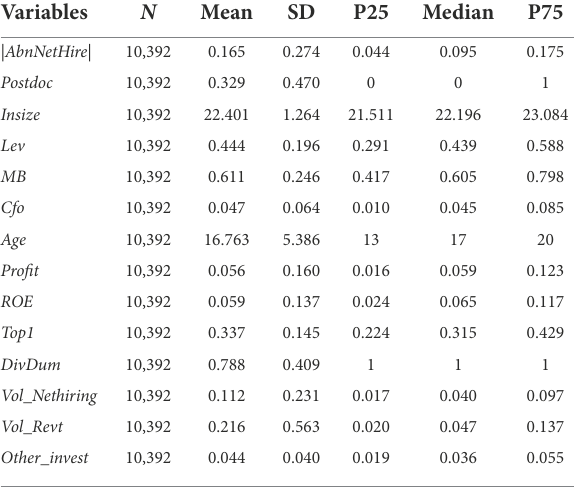
TABLE 2 Summary statistics for key